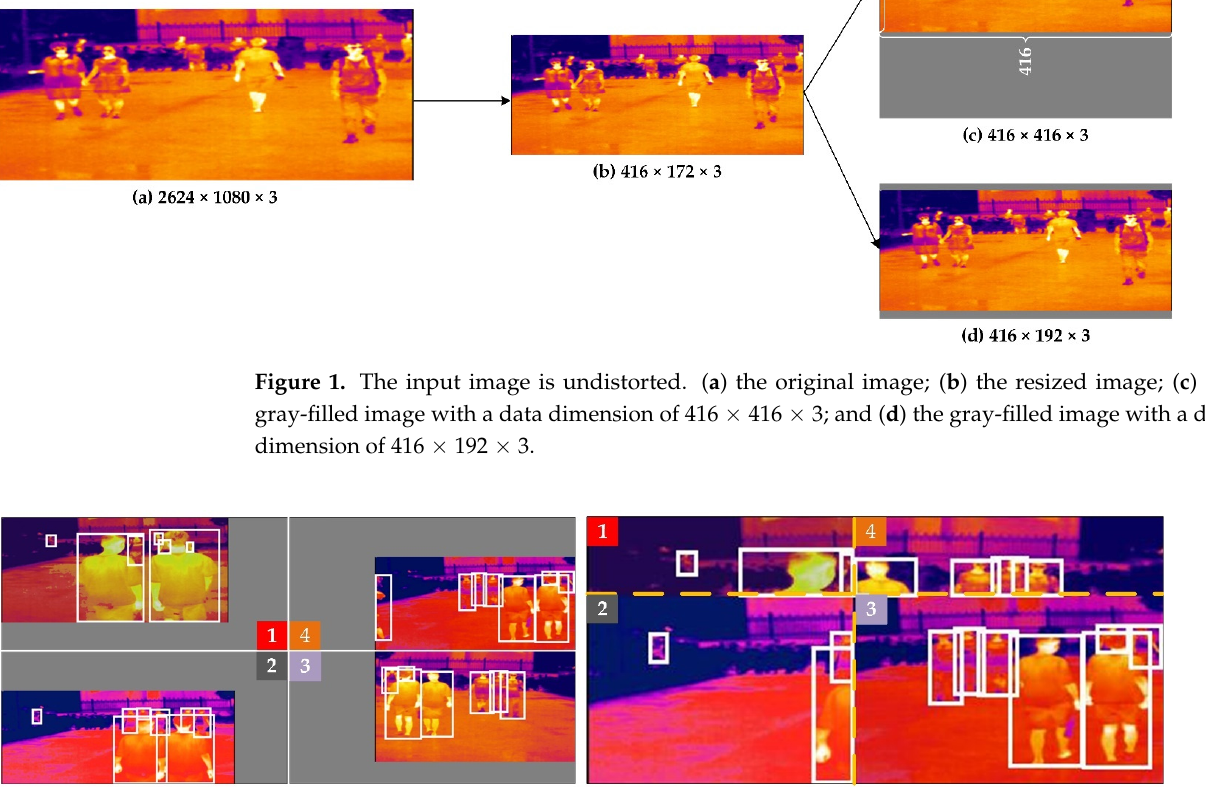
Figure 1. The input image is undistorted. ( a ) the original image; ( b ) the resized image; ( c ) the gray- filled image with a data dimension of 416 × 416 × 3; and ( d ) the gray-filled image with a data dimen- sion of 416 × 192 × 3.